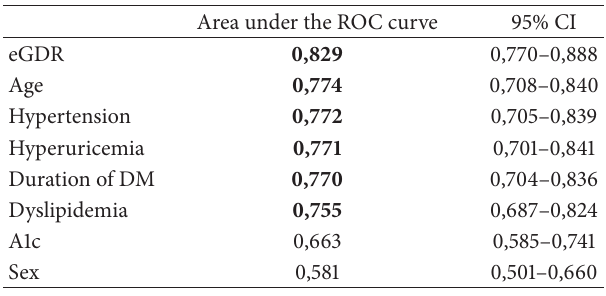
Table 4: Area under the ROC curve analysis for statistically significant parameters associated with CKD.